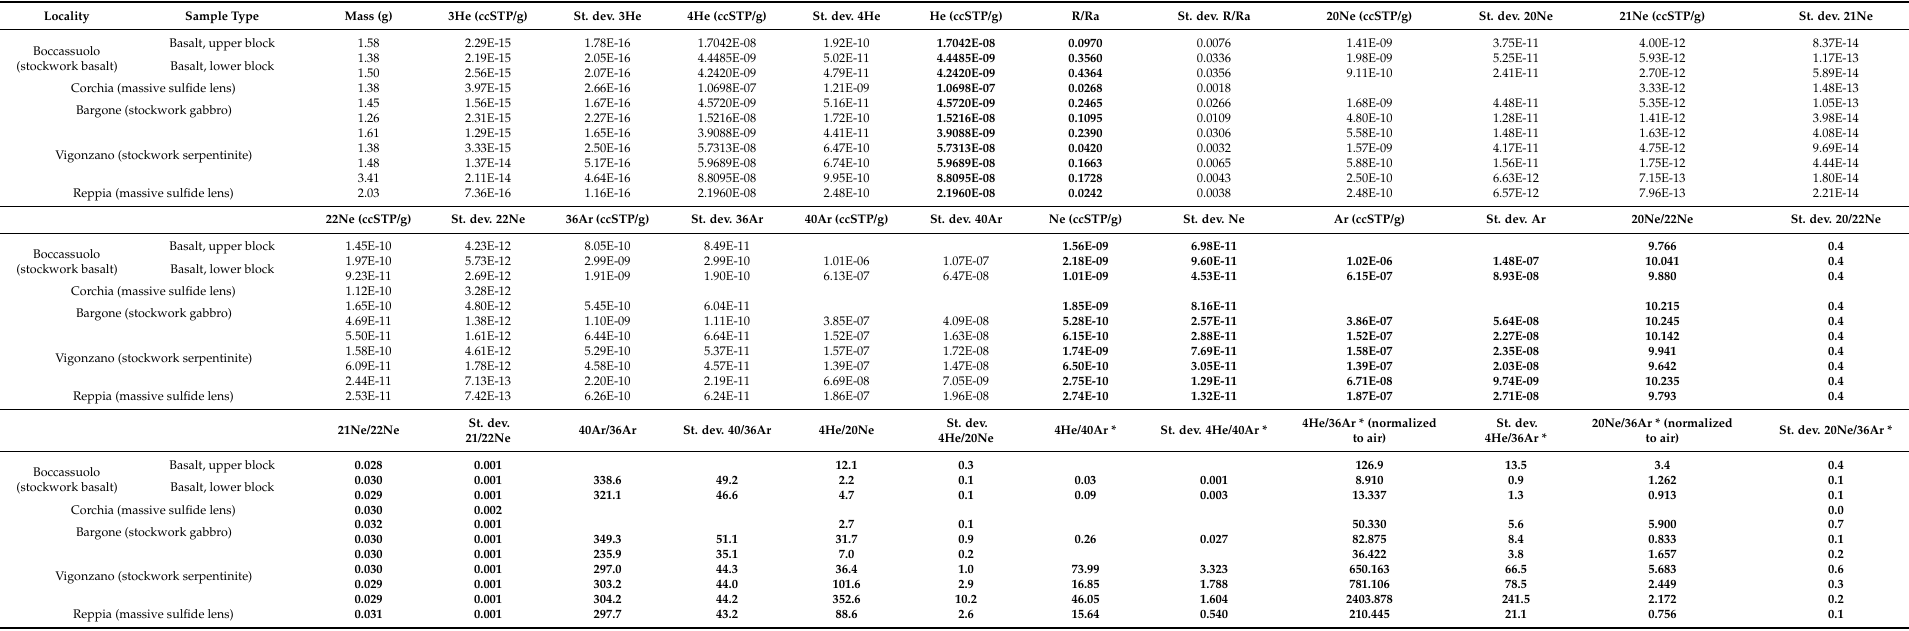
Table A2. Summary of noble gas isotope measurement